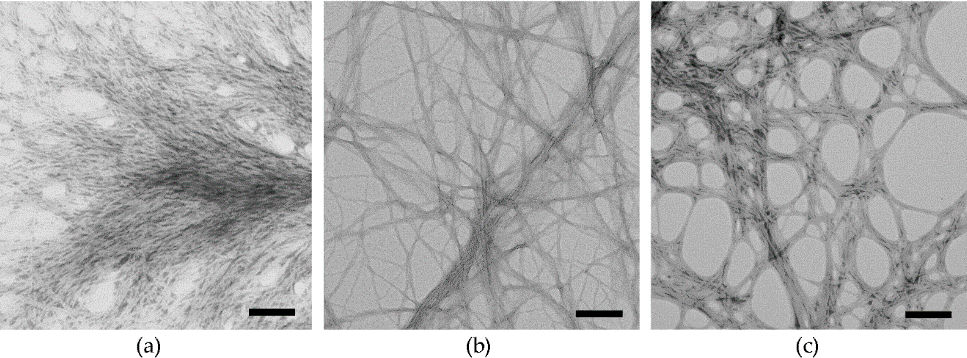
Figure 2. TEM micrographs of ( a ) 1 , ( b ) 2 , and ( c ) 3 nanofibrils (25 mM). Scalebar = 200 nm.